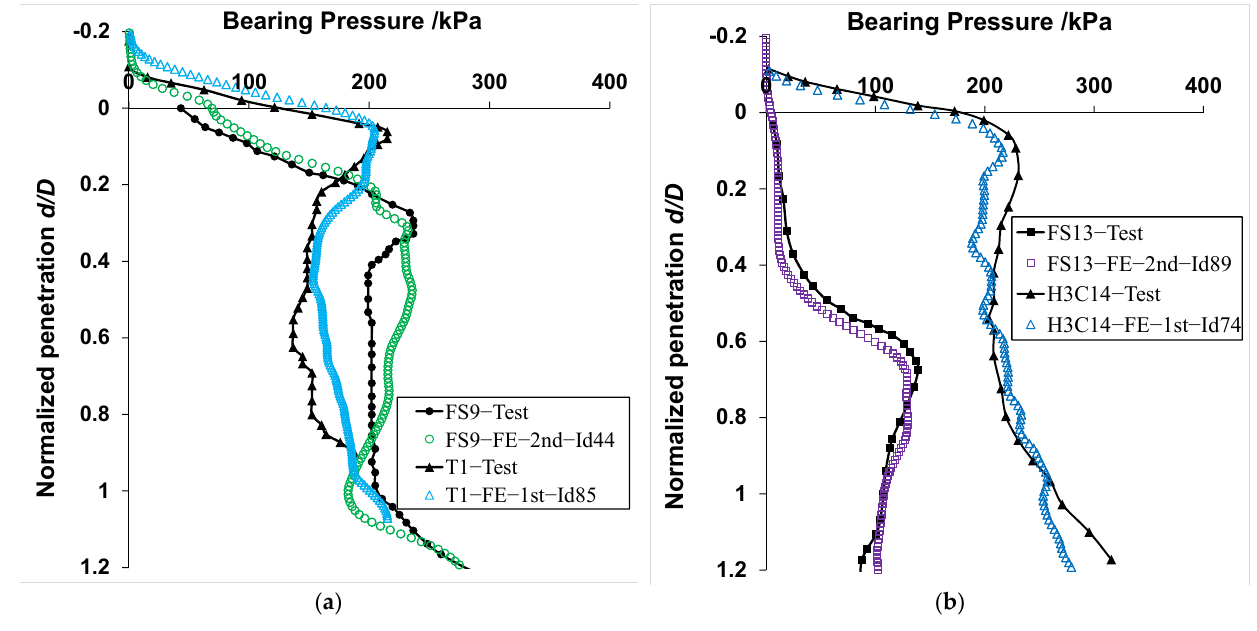
Figure 3. Comparison of resistance profiles of spudcan from centrifuge tests and numerical analyses: ( a ) test FS9 and T1; ( b ) test FS13 and H3C14.